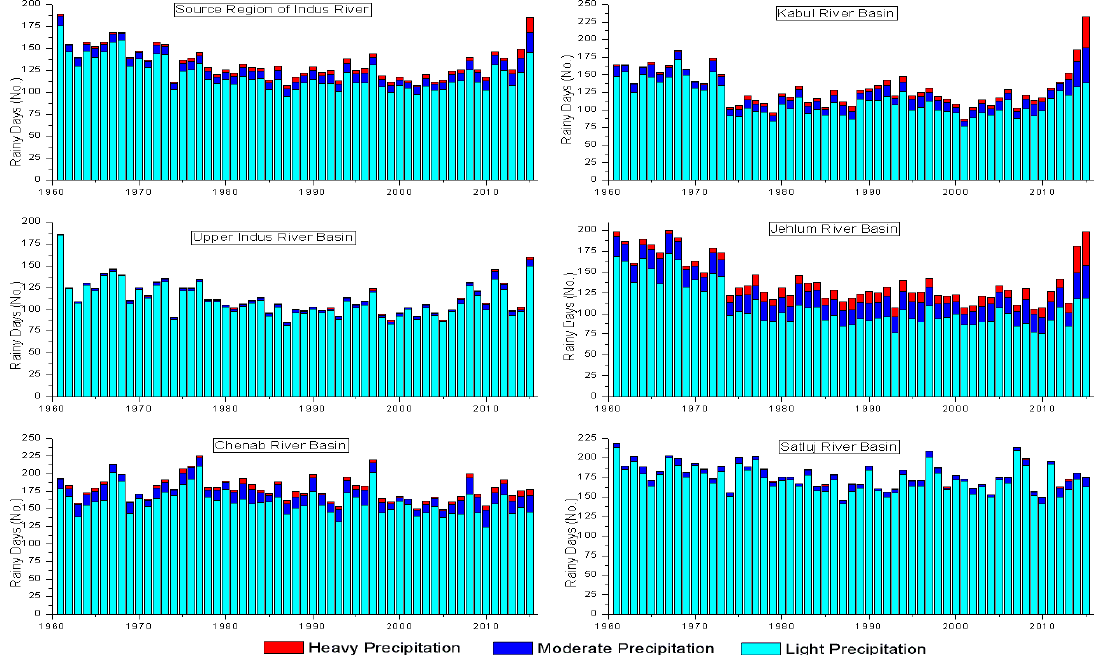
Figure 9. Distribution of rainy days for light, moderate, and heavy precipitation.